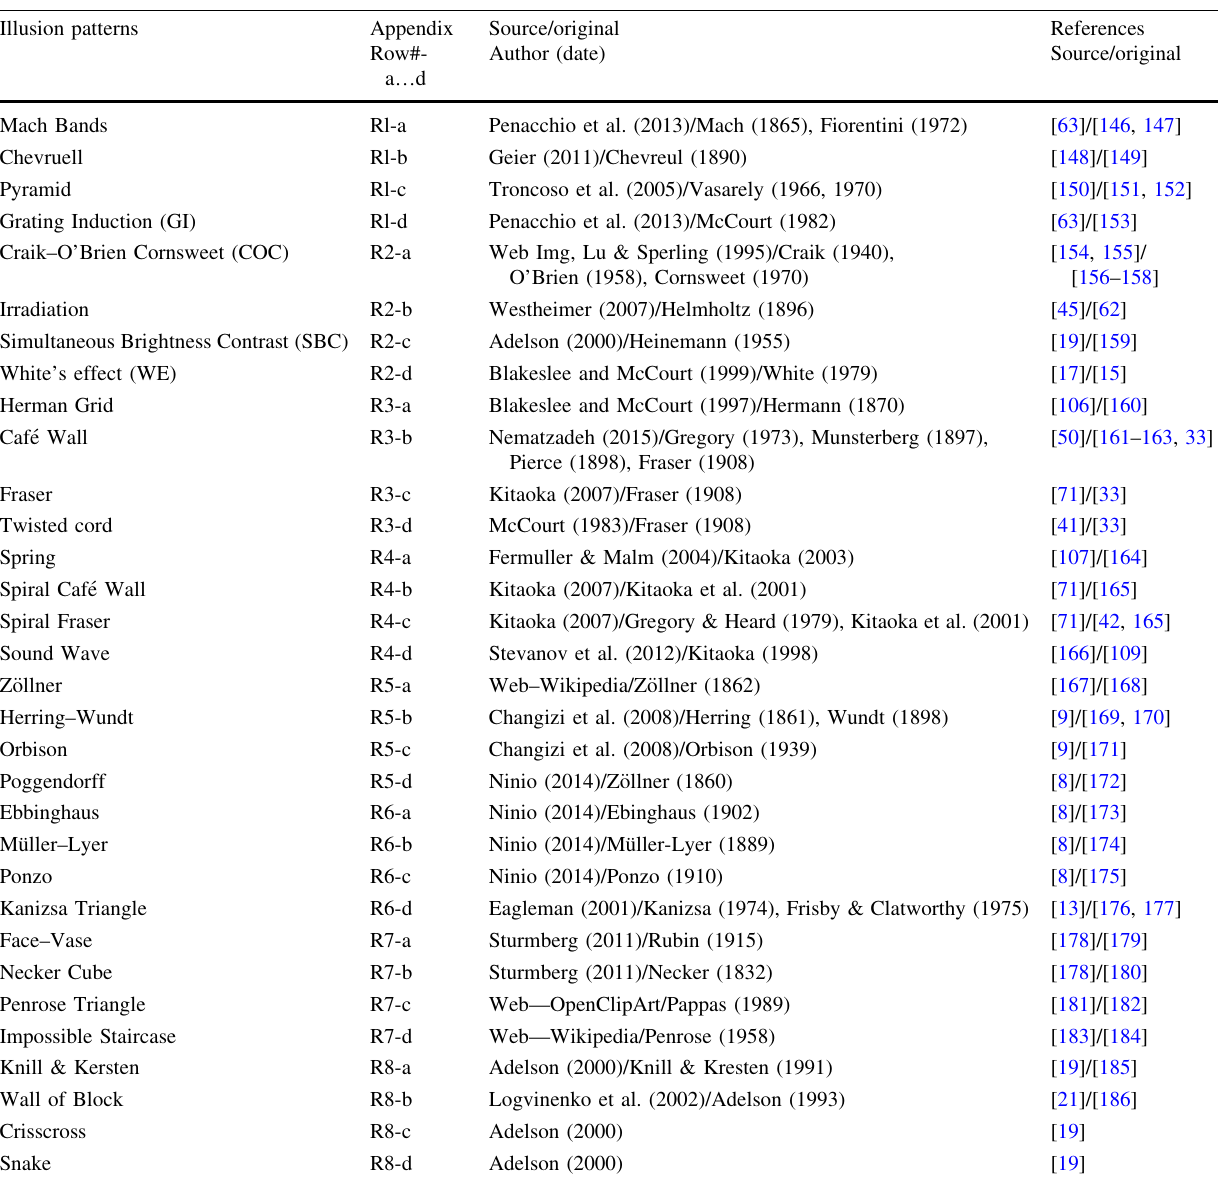
Table 2 The source and original references of the illusion patterns in Table 1 Illusion